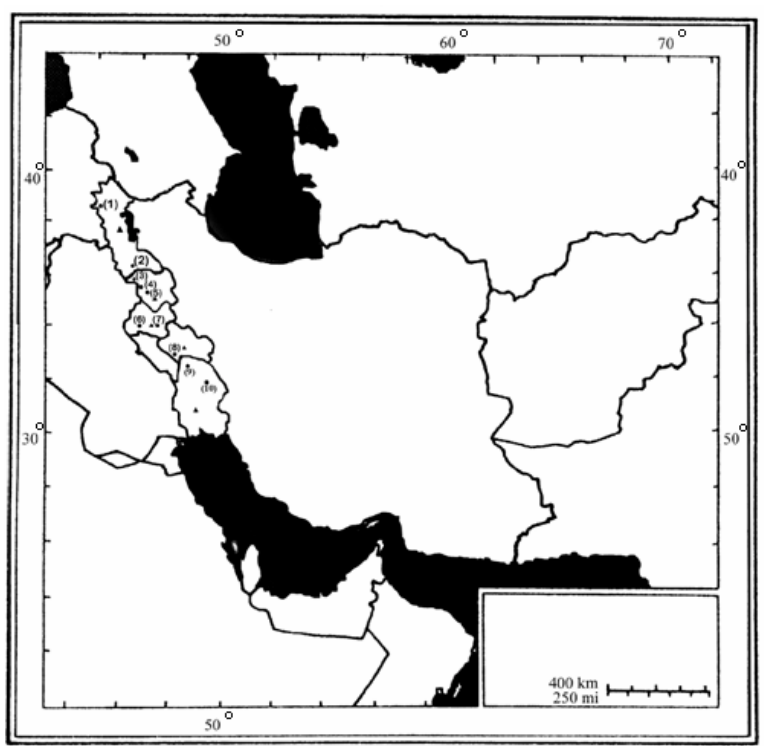
_ F IG .1. Map of sampling localities for specimens used in this study: (1) Ghotur; 38˚,35 (cid:1171) N – 45˚,02 (cid:1171) E (2) Bukan; 36˚,32 (cid:1171) N – 46˚,10 (cid:1171) E (3) Baneh; 35˚,58 (cid:1171) N – 45˚,55 (cid:1171) E (4) Marivan; 35˚,22 (cid:1171) N – 46˚,14 (cid:1171) E (5) Sarvabad; 35˚,17 (cid:1171) N – 46˚,21 (cid:1171) E (6) Esalm Abad - e- Gharb; 34˚,19 (cid:1171) N – 47˚,07 (cid:1171) E (7)